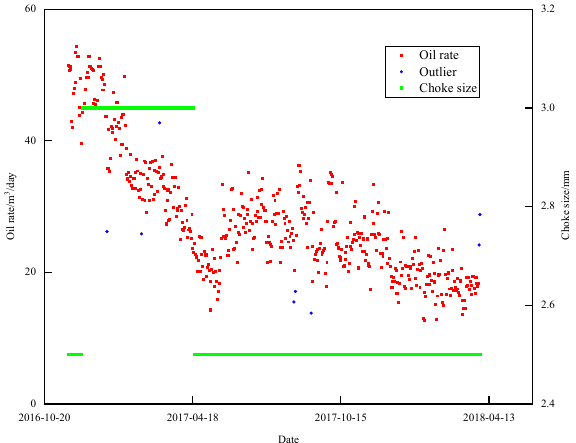
Figure 6. The scatter diagram of on-site sample data.